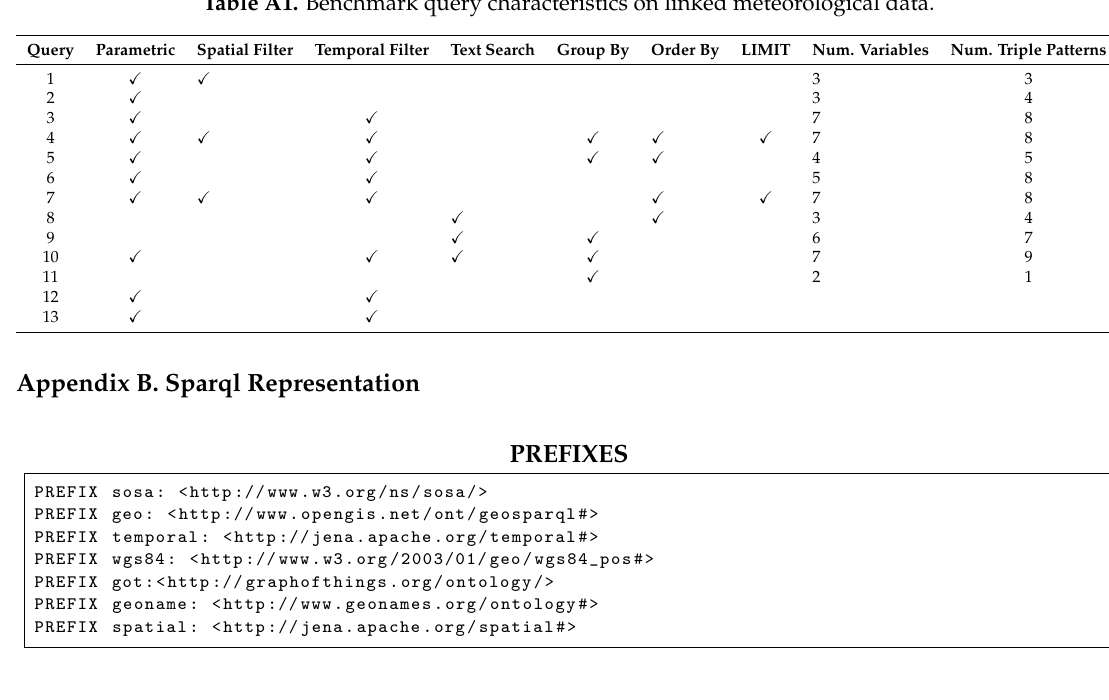
Table A1. Benchmark query characteristics on linked meteorological